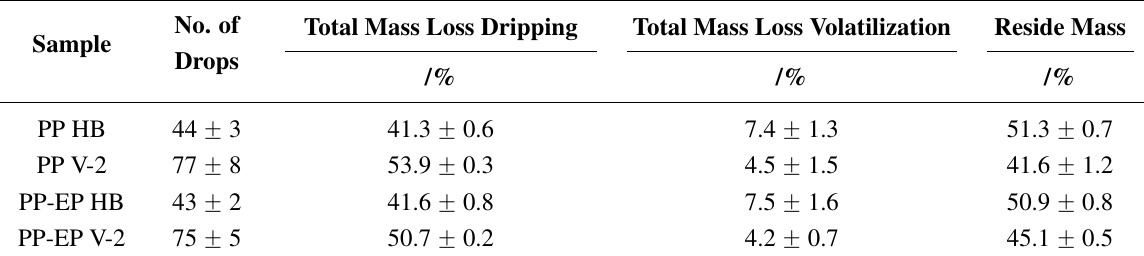
Figure 5. Mass loss as a function of time of: ( a ) PP-EP HB at various furnace temperatures; and ( b ) PP HB, PP V-2, PP-EP HB and PP-EP V-2 at 500 °C. Table 5. Summary of melt dripping results for PP HB, PP V-2, PP-EP HB and PP-EP V-2 at 500 °C.